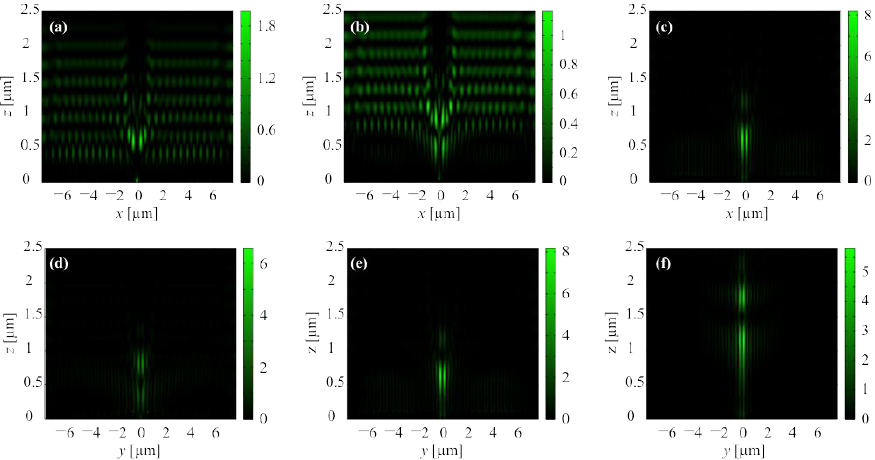
Figure 8. The instantaneous longitudinal of the intensity of the second-order CVB focused by aluminum BZP pattern in XZ-plane ( a – c ) and YZ-plane ( d – f ) at the time moment of 100.07 fs ( a , d ), 114.08 fs ( b , e ), and 188.13 fs ( с , f ).